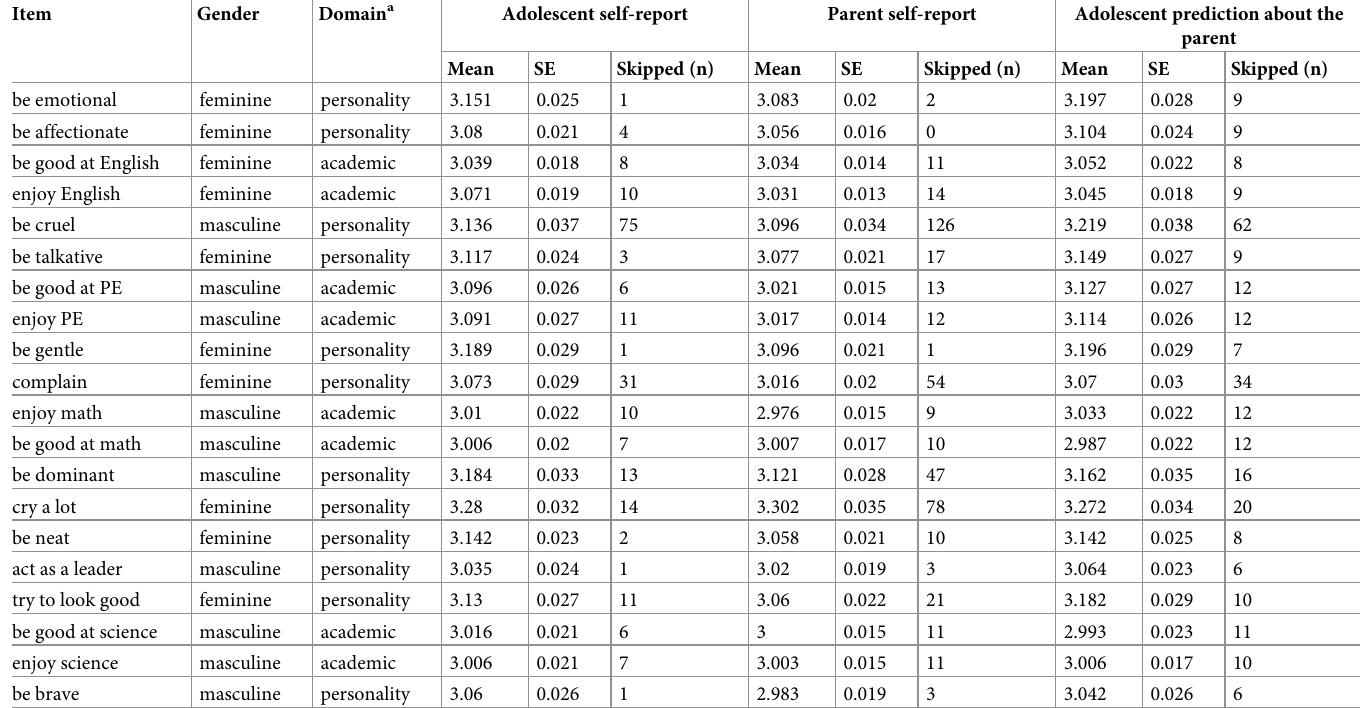
Table 3. Items on the trait subscale of the OAT-AM with means, standard deviations, and the number of participants who skipped each